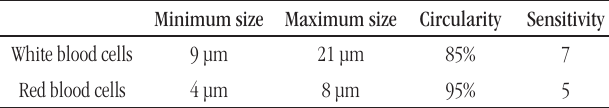
taBLE − Parameters in cell counting using Countess™ Minimum size Maximum size